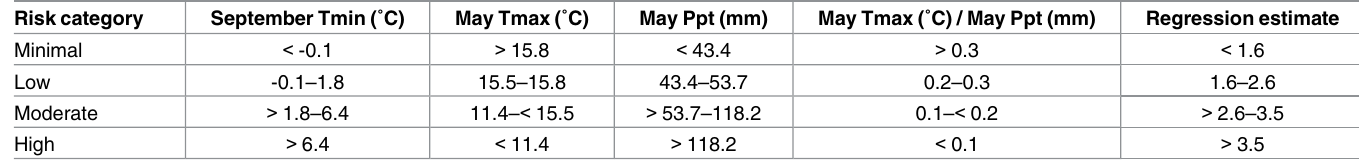
Table 3. Predictor variable and regression estimate ranges for the BWA damage risk categories identified in the ANOVA analysis. Tmin, Tmax and Ppt represent averageminimum temperature, maximum temperature and total precipitation for 30-year climate normals (1981–2010). Risk category val- ues are defined by the non-overlappingranges of regressionestimates for the low damage (1.6–3.5) and severe damage (2.6–3.8)